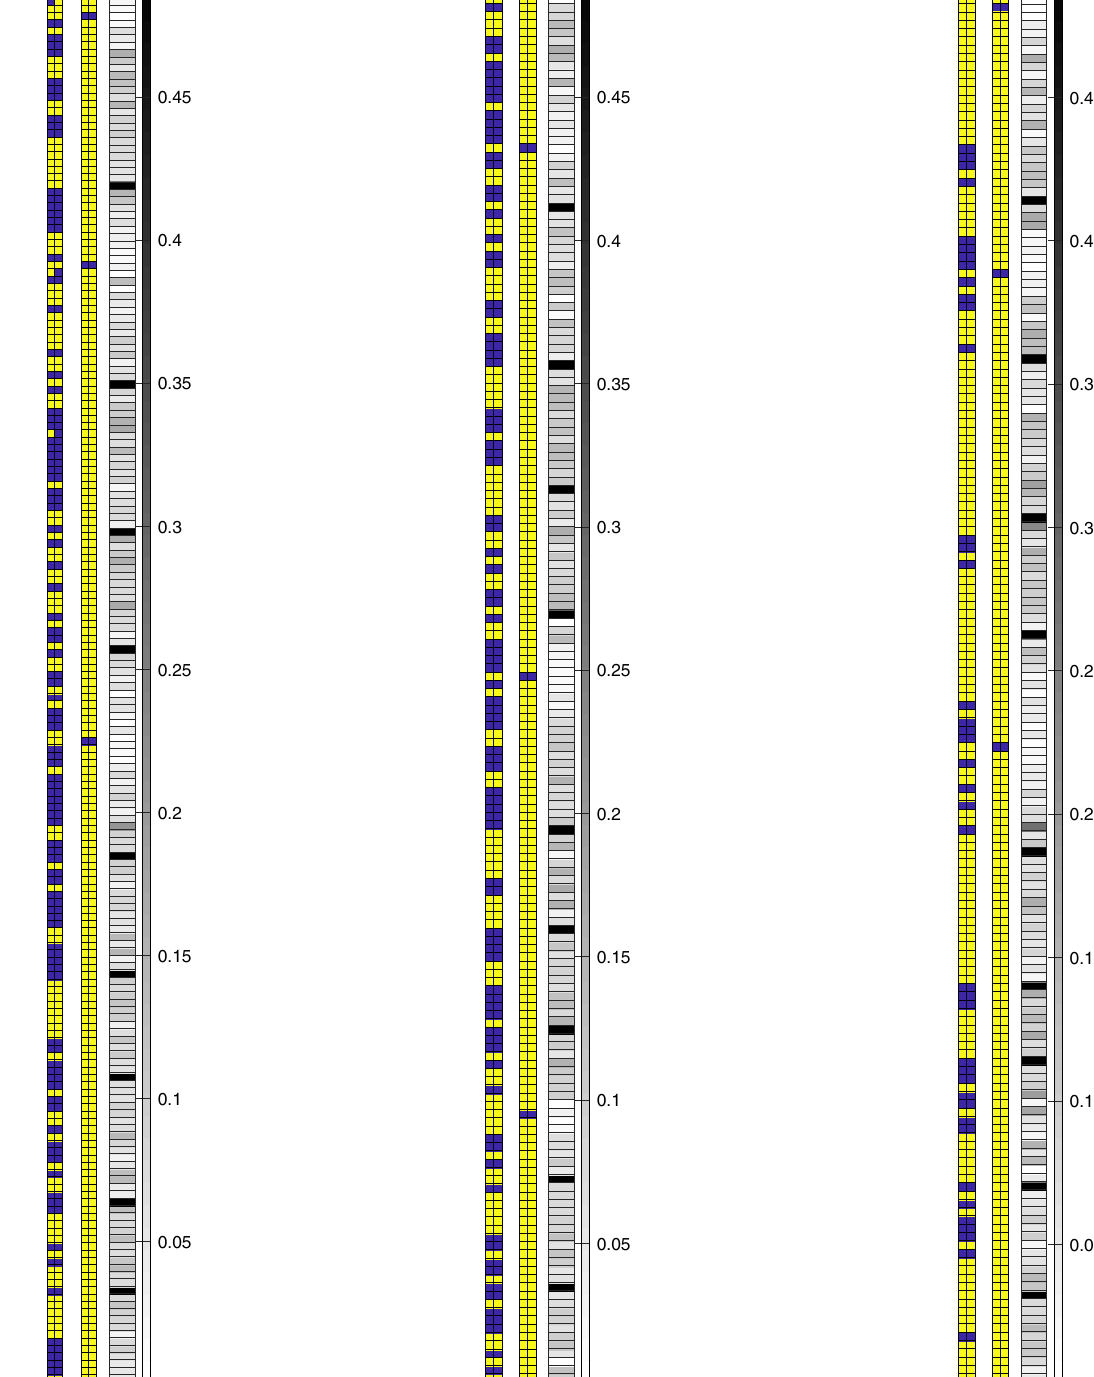
Figure 3. Donors and recurrent parents’ genetic information and recombination frequencies for three cases (DR: donor, RP: recurrent parent, r: recombination frequency). A yellow square is used to denote a favorable allele (“1”) and a purple square is used to denote an unfavorable allele (“0”). The gray charts are heat maps for recombination